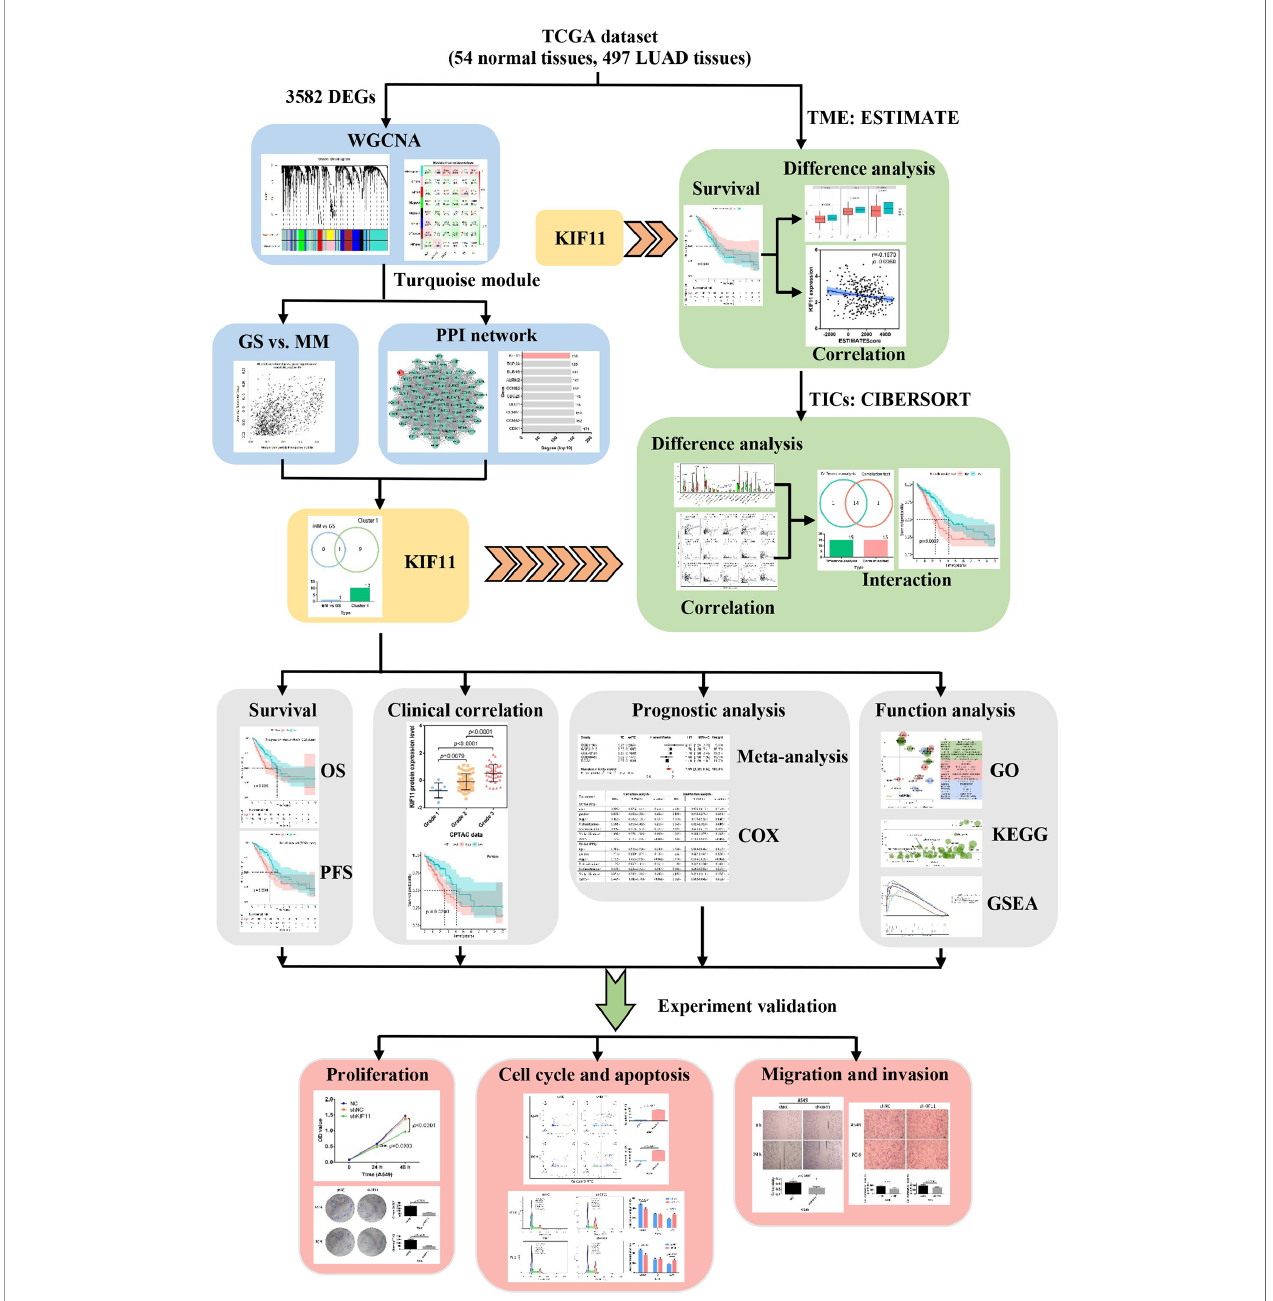
FIGURE 1 | Flow diagram of the KIF11 identi fi cation work fl ow for LUAD. TCGA, the Cancer Genome Atlas; LUAD, lung adenocarcinoma; WGCNA, weighted gene co-expression analysis; DEGs, differentially expressed genes; OS, overall survival; PFS, progression-free survival; TME, tumor microenvironment; TICs, tumor- in fi ltration immune cells; GO, gene oncology; KEGG, kyoto encyclopedia of genes and genomes; GSEA, gene set enrichment